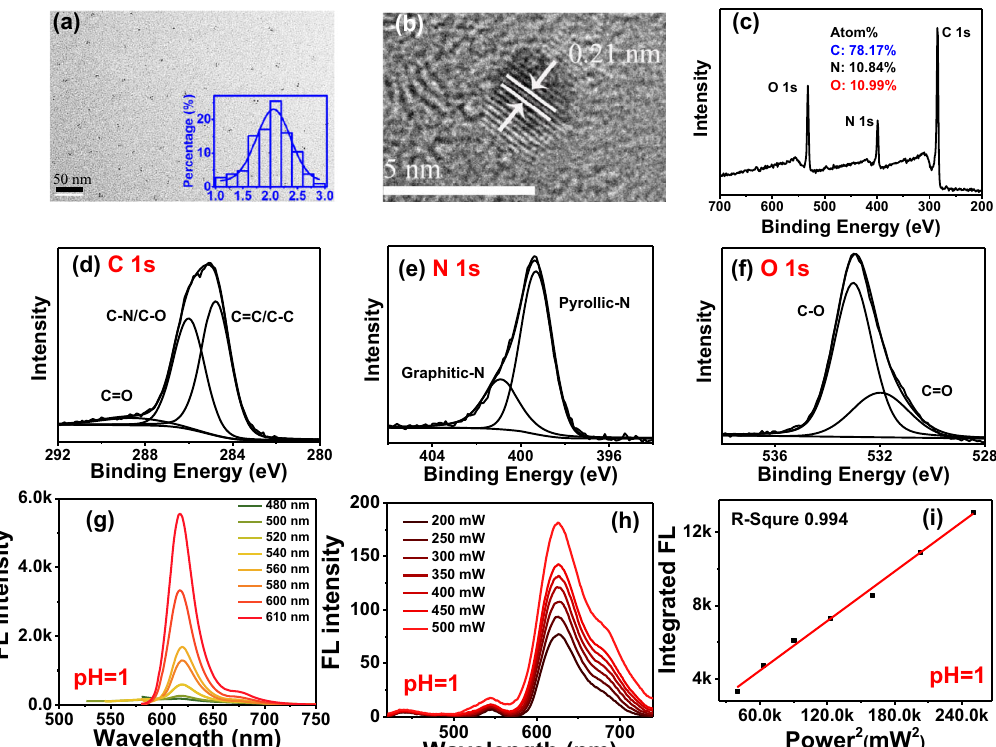
Fig. 1 Structure, composition, and optical properties of protonated CDs. a TEM image of CDs (inset, particle size distribution of CDs); b high-resolution TEM image of CDs; c − f : full scale XPS spectra, high-resolution C 1s, N 1s, and O 1s XPS spectra of CDs; g , h one-photon and two-photon fl uorescence (FL) spectra of protonated CDs in deionized water; i relationship of two-photon FL intensity and femtosecond (fs) laser